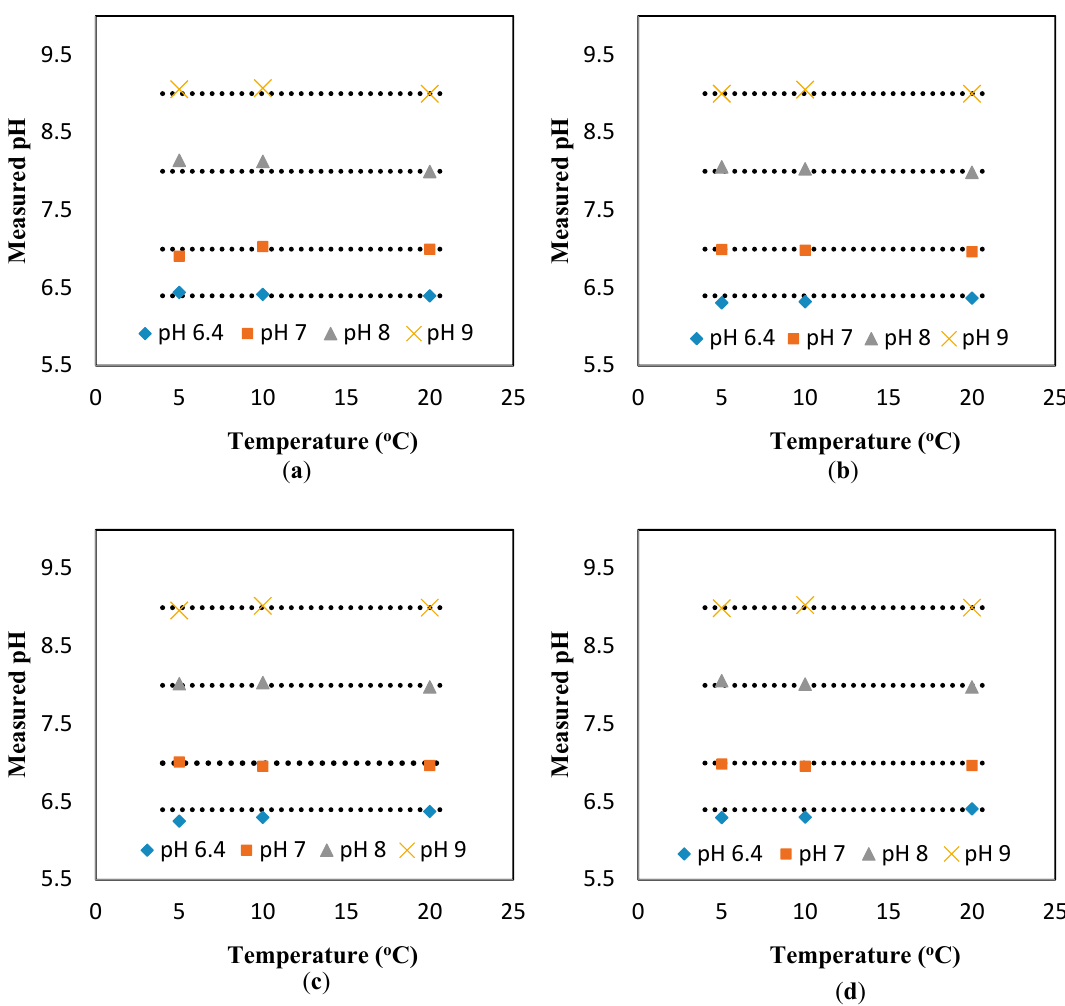
Figure 2. The measured pH after adding the compensation factor (a function of measured pH and temperature) at flowrate ( a ) 0 mL/min; ( b ) 10 mL/min; ( c ) 20 mL/min; and ( d ) 30 mL/min.